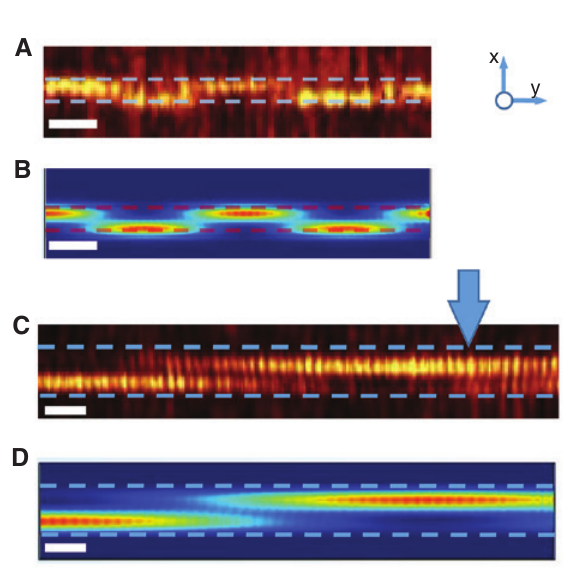
Figure 4: (A) An NSOM image of a 0.90- μ m-wide waveguide excited with horizontally polarized light and (B) a Comsol calculation of the electric field (square-magnitude) for the same waveguide. (C) NSOM image of a 2.38- μ m-wide waveguide excited with horizontally polar- ized light and (D) a Comsol calculation of the electric field (square- magnitude) for the same waveguide. All scale bars are at 2 μ m. All dotted lines indicate the outline of the waveguide.